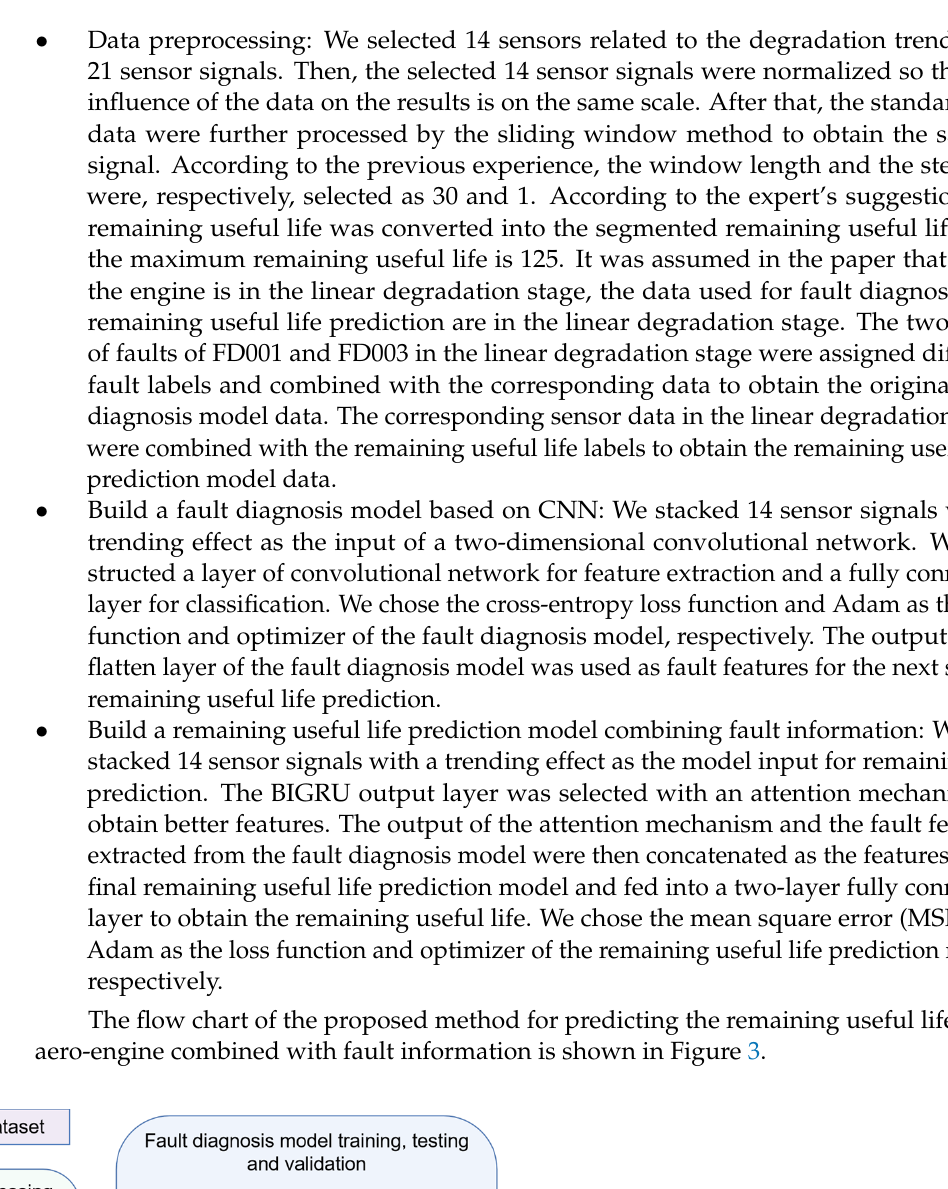
2 Table 2. Dataset sensor detailed description. Index